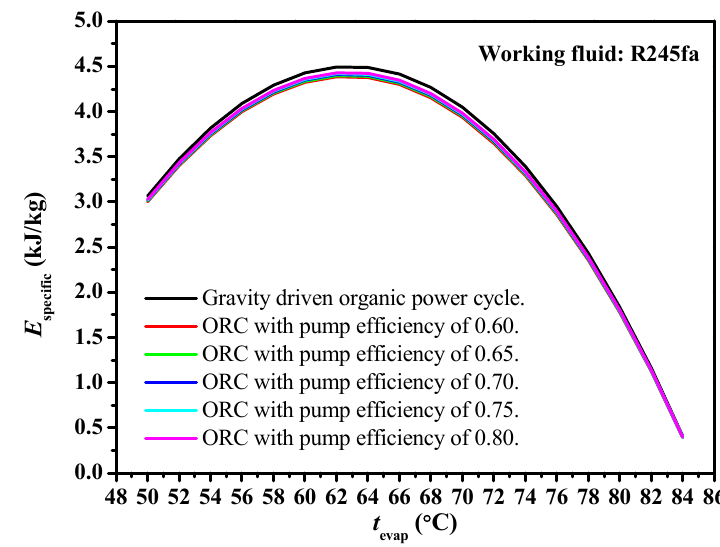
Figure 4. The specific energy comparison between GDOPC and ORC.